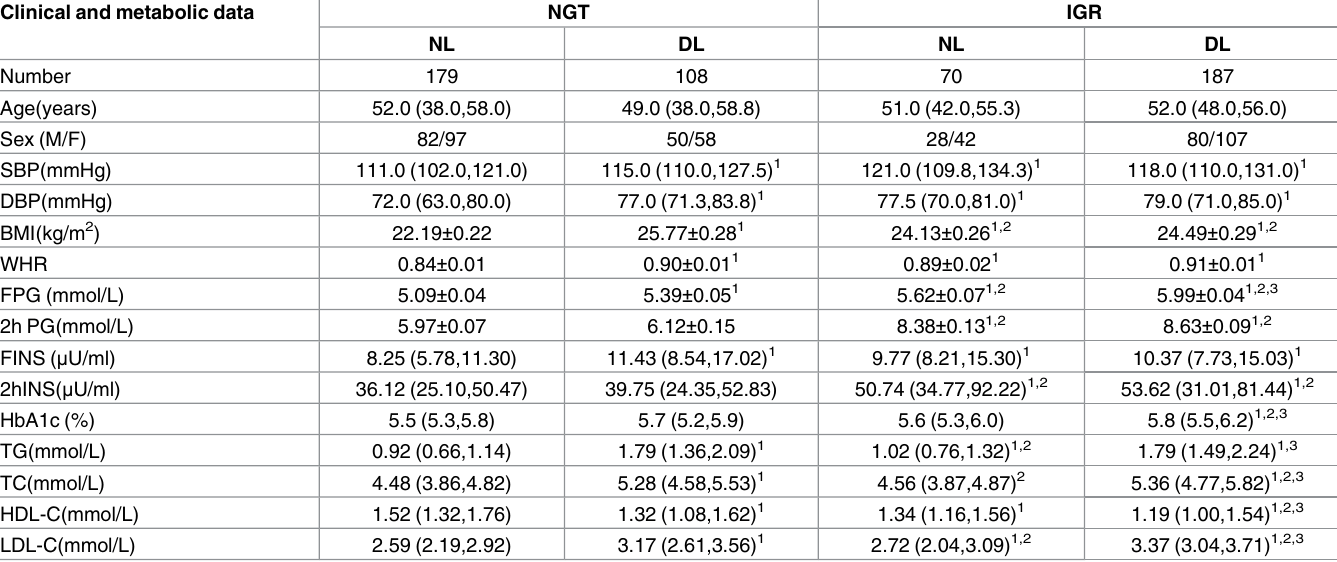
Table 1. Characteristics of the subjects according to glucose tolerance and serum lipid status. Clinical and metabolic